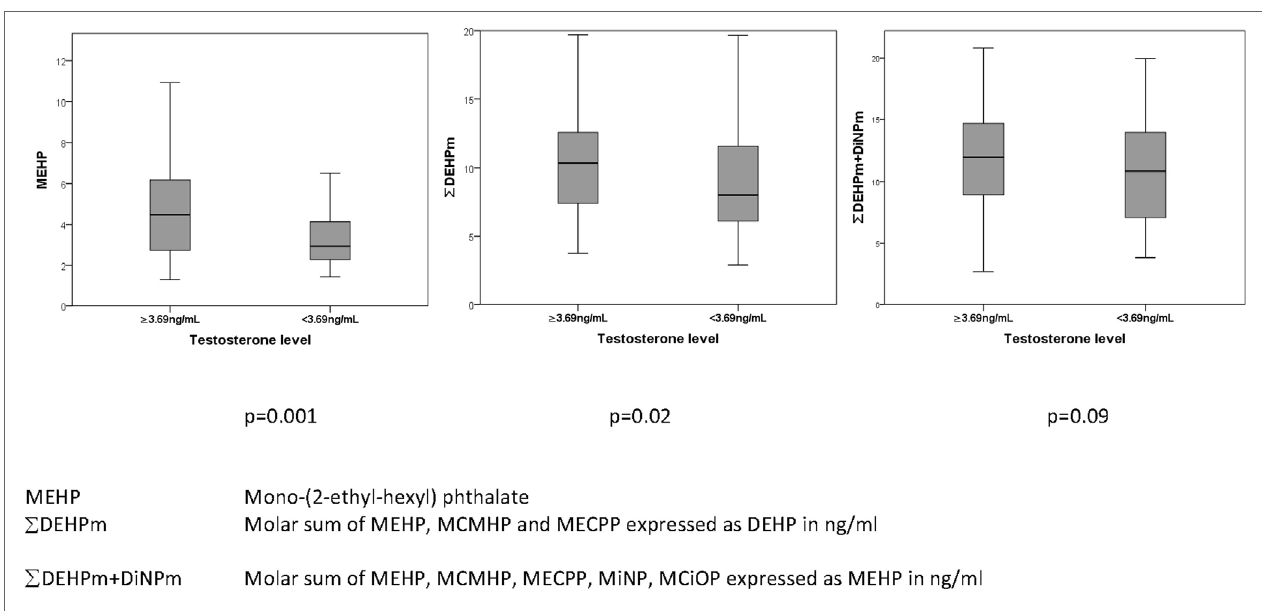
FigUre 2 | Association of prenatal maternal serum phthalates (nanograms/milliliter) with total serum testosterone (nanograms/milliliter) in their adult